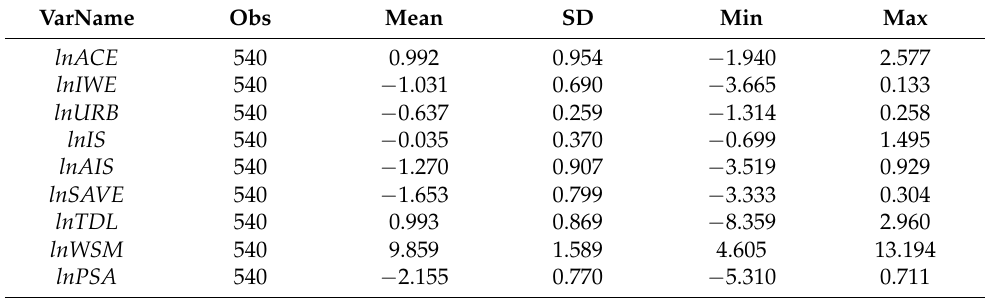
Table A2. Variable descriptive